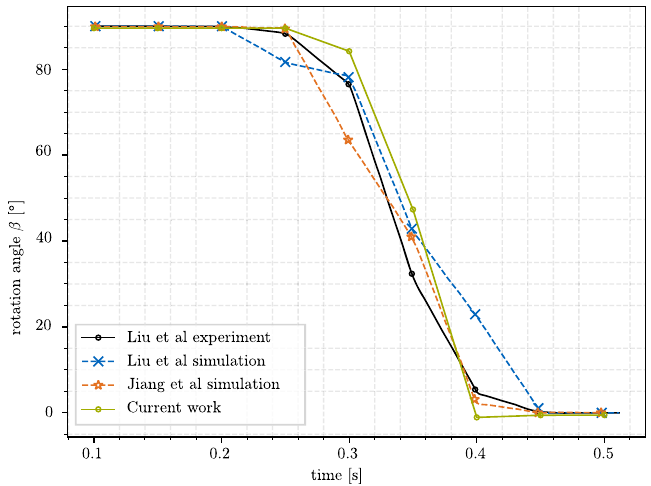
Fig. 11 Rotation angle of the second block compared to the experiment [36] and the numerical solutions of Liu et al. [36] and Jiang et al [37]